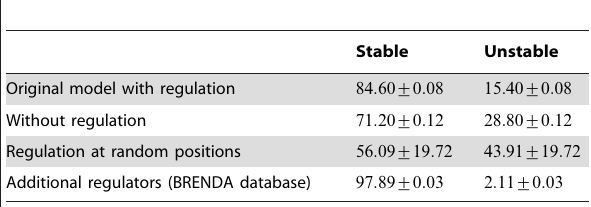
Table 1. The impact of regulation on plant energy